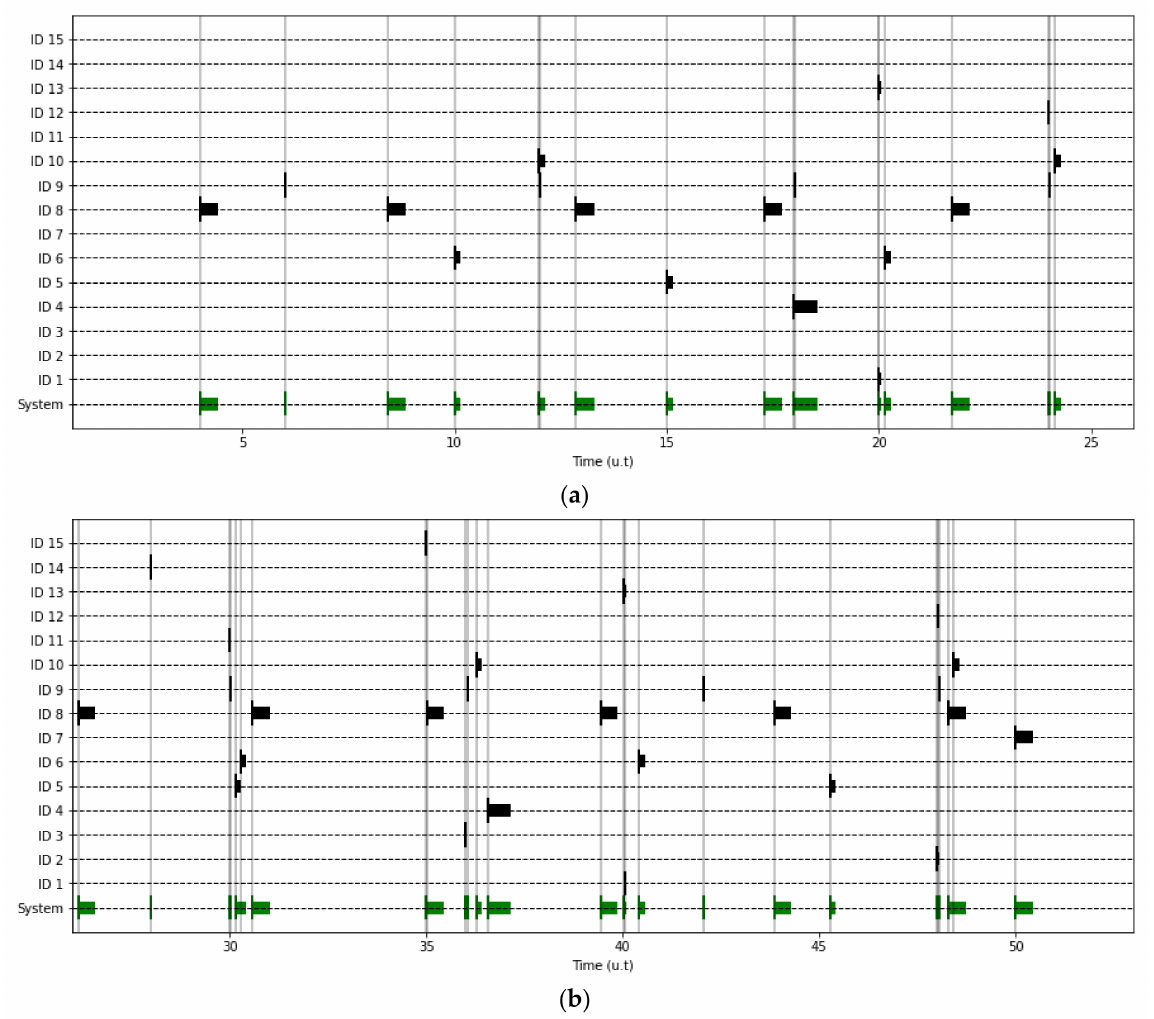
Figure 7. Optimal grouping schemes for the case study under tolerance factor e = 0%, considering a 52-week planning horizon. ( a ) First semester (weeks 1–26); ( b ) Second semester (weeks